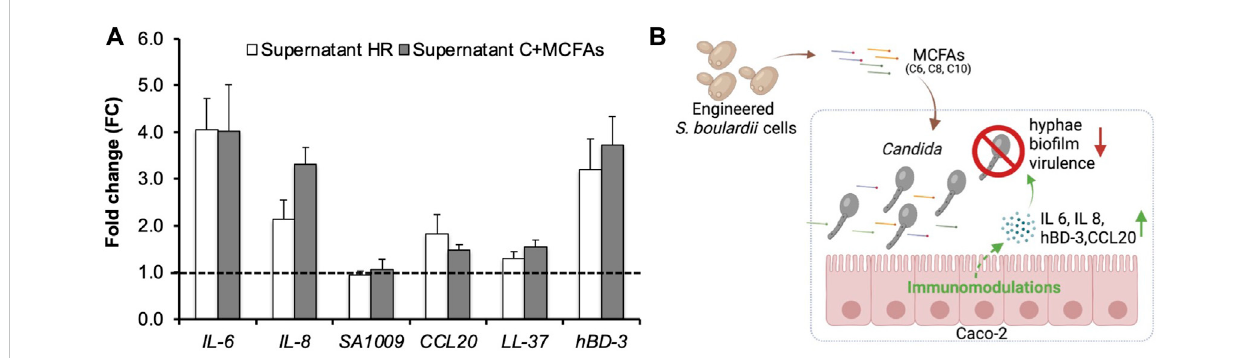
FIGURE 5 RT-PCRanalysisofgenesinvolvedinimmunomodulationinCaco-2cellsandtheproposedmechanismoftheMCFAs ’ anti- Candida effects.Caco-2 cells were co-cultured with C. albicans and the MCFA-containing supernatant of CLPY04. (A) . Real-time PCR analysis. Expression of genes related to immunomodulation at 3.5 h was analyzed. The supernatant from the strain CLPY01 (Supernatant C) was used as a control. MCFAs were spiked into Supernatant C (Supernatant C + MCFAs) and used as a positive control. Reference gene, ACT1 . A dotted line indicates FC1.0, representing the fold change of genes from the control. The pH ofSupernatant C and Supernatant HR was adjusted to 5.5 prior to co-culturing. (B) . The proposed mechanism ofanti- Candida effect byMCFAs.Reduction of Candida ’ shyphae and bio fi lmformations,and virulence-relatedgenes as well as theupregulationof IL-6, IL-8, human beta-defensin 3 (hBD-3), and CCL20 genes are indicated by arrows. The box in blue indicates the co-culturing of C. albicans cells, MCFA- containing supernatant, and Caco-2